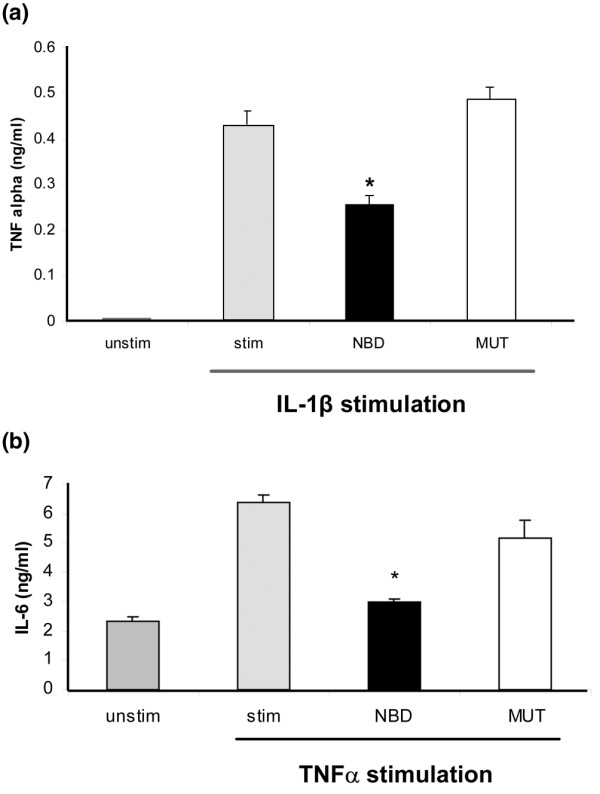
NBD peptide blocks pro-inflammatory cytokine production by human macrophages in vitro and rheumatoid arthritis (RA) synovial biopsies ex vivo. (a) NBD peptide blocks interleukin (IL)-1-β-induced tumor necrosis factor (TNF)-α production by human macrophages in vitro. Macrophages were pre-incubated with either NBD or mutant NBD (MUT) peptide at a concentration of 50 μM for 2 hours. Subsequently, cells were stimulated with IL-1-β (2.5 ng/ml). After 24 hours, supernatants were collected, and TNF-α levels were measured by sandwich enzyme-linked immunosorbent assay (ELISA). Data are representative of three independent experiments performed in triplicates and are expressed as mean ± standard error of the mean (SEM) (*p < 0.01). (b) NBD peptide blocks TNF-α-induced IL-6 production of RA synovial biopsies ex vivo. Synovial biopsies were cultured with TNF-α (10 ng/ml) in the presence or absence of NBD peptides (100 μM). After 7 days, supernatants were collected and IL-6 levels were measured by sandwich ELISA and corrected for weight of the biopsy. Data are representative of three independent experiments performed in triplicates and are expressed as mean ± SEM (*p < 0.01).